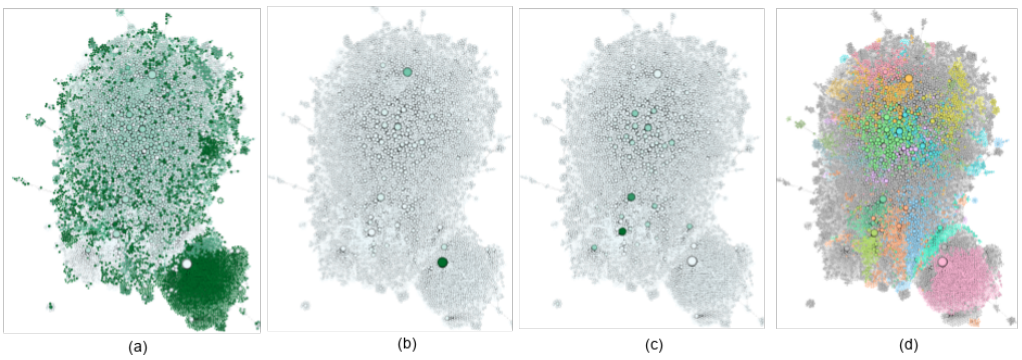
Figure 8. Isolating the inner core and colour-coding based on different measures—( a ) closeness centrality, ( b ) in-degree, ( c ) out-degree, ( d )